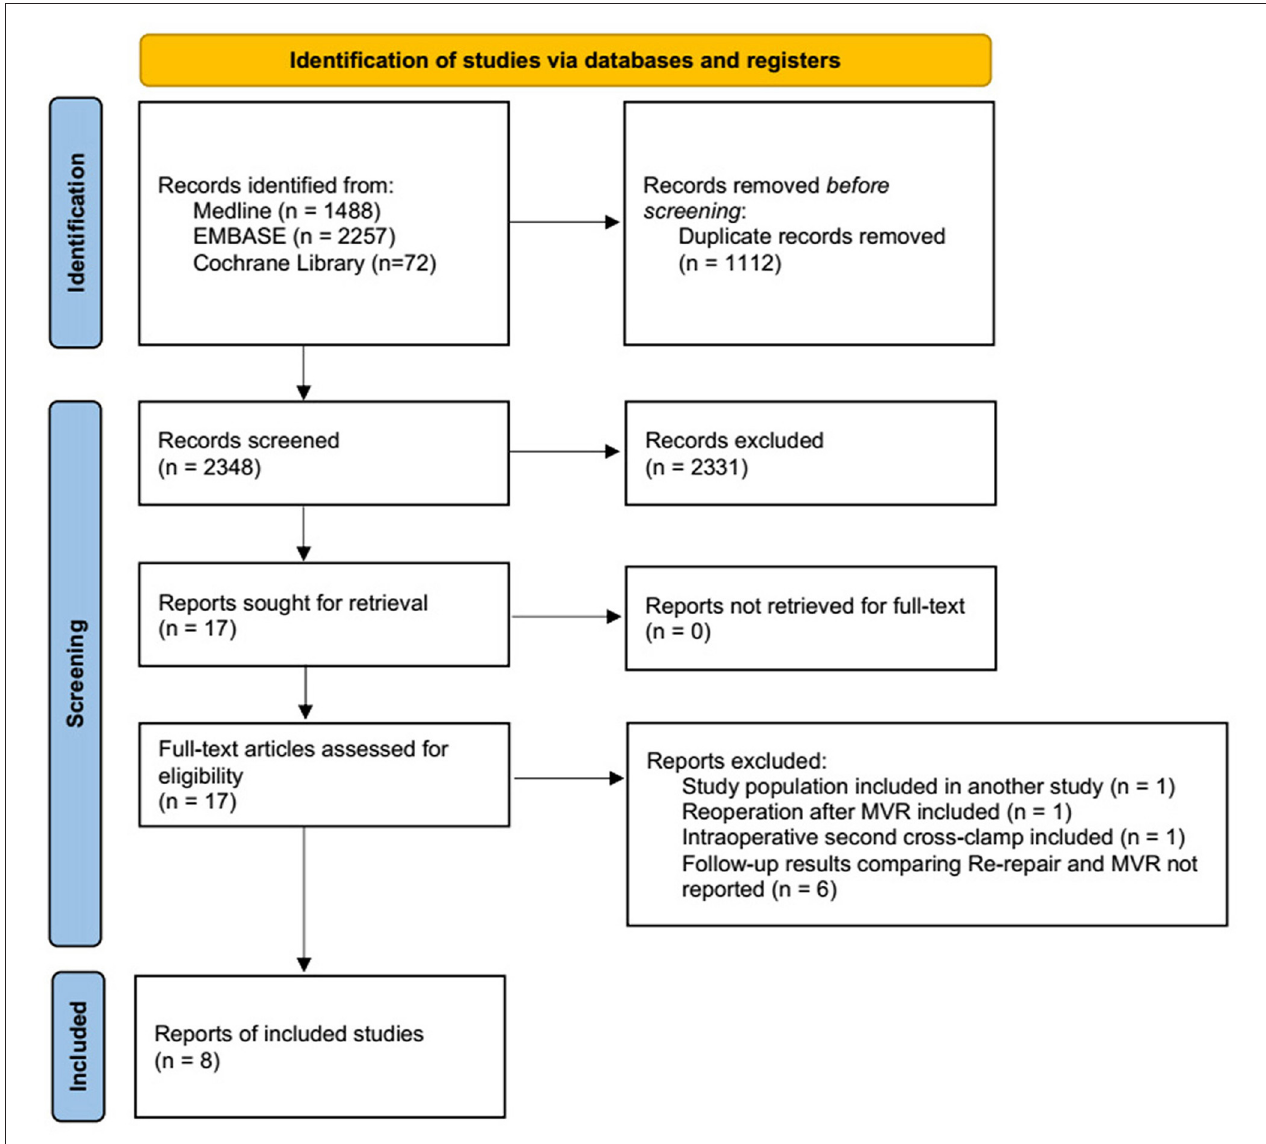
FIGURE 1 | PRISMA flow chart depicting the selection of studies included in the meta-analysis. PRISMA, Preferred Reporting Items for Systematic Reviews and Meta-analyses; MVR, mitral valve